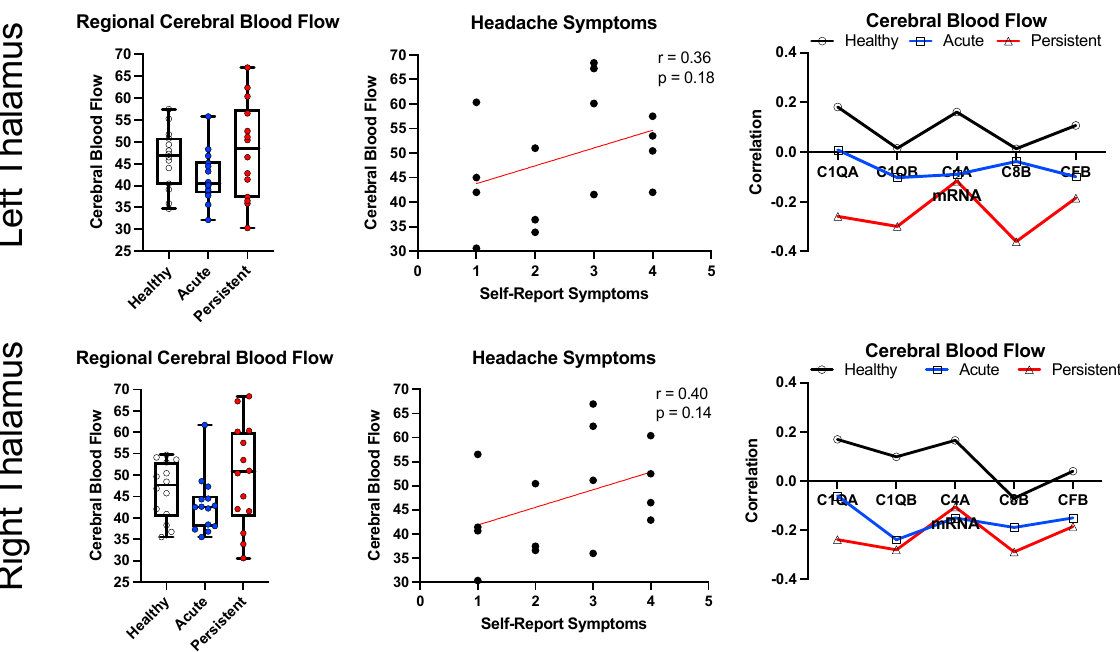
Figure 5. Regional cross-modal analysis for the bilateral thalamus. Data is presented for cerebral blood flow ( left ), the correlation between cerebral blood flow and self-reported headache symptoms ( middle ), and the correlation between CBF and inflammatory markers ( right ).